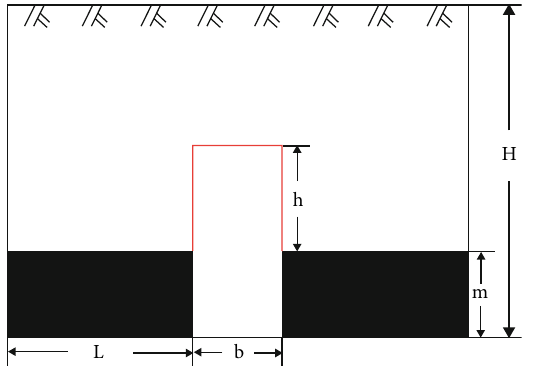
Figure 11: Schematic diagram of working face width, yield zone, and falling